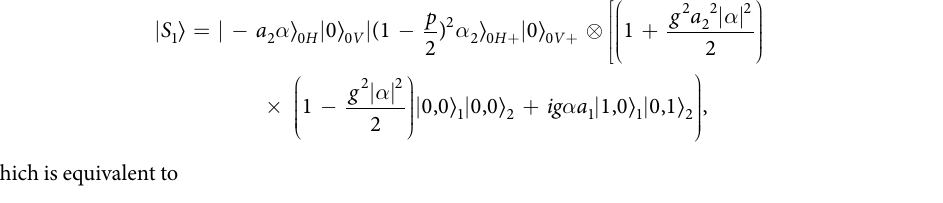
in (1 − F 0 ), and there is a − F 1 2